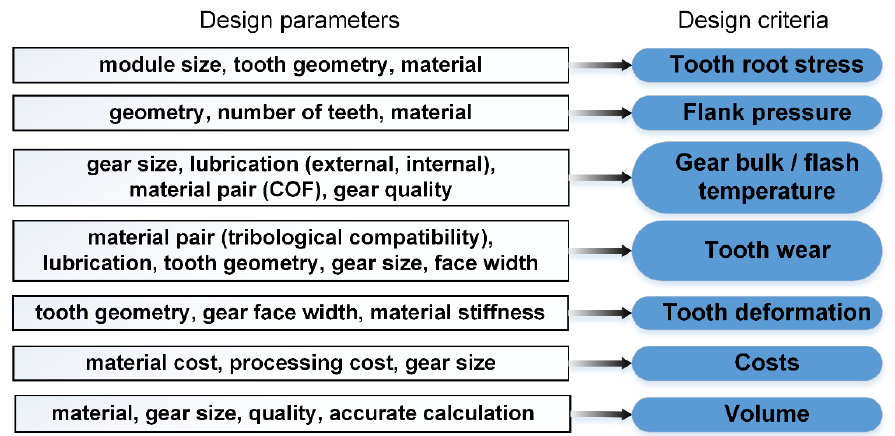
Figure 7. Gear pair design parameters and how to influence design criteria.